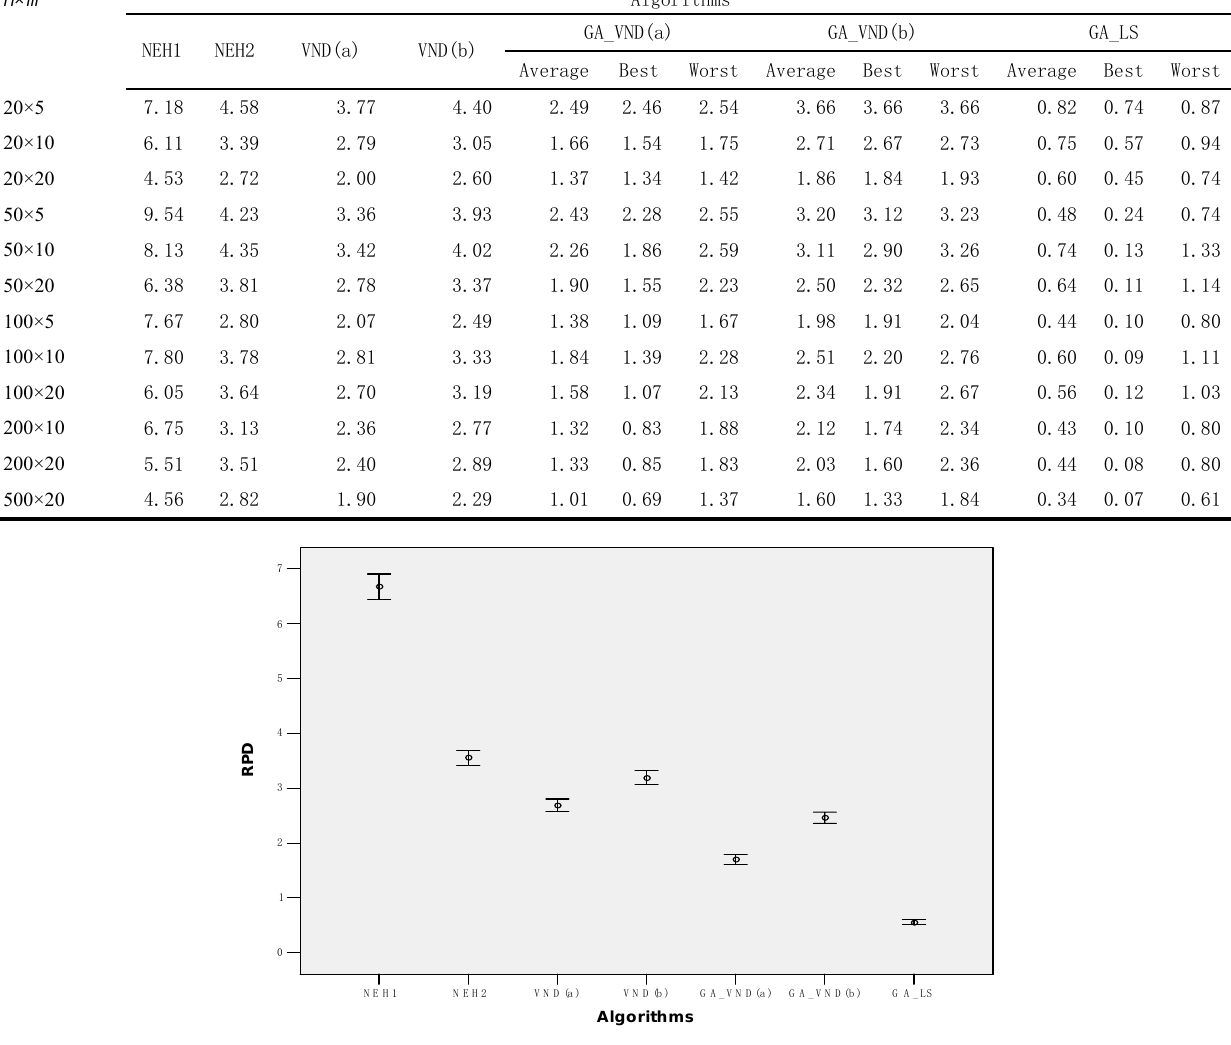
Table 3. Average relative percentage deviation (RPD) of algorithms grouped by n and m